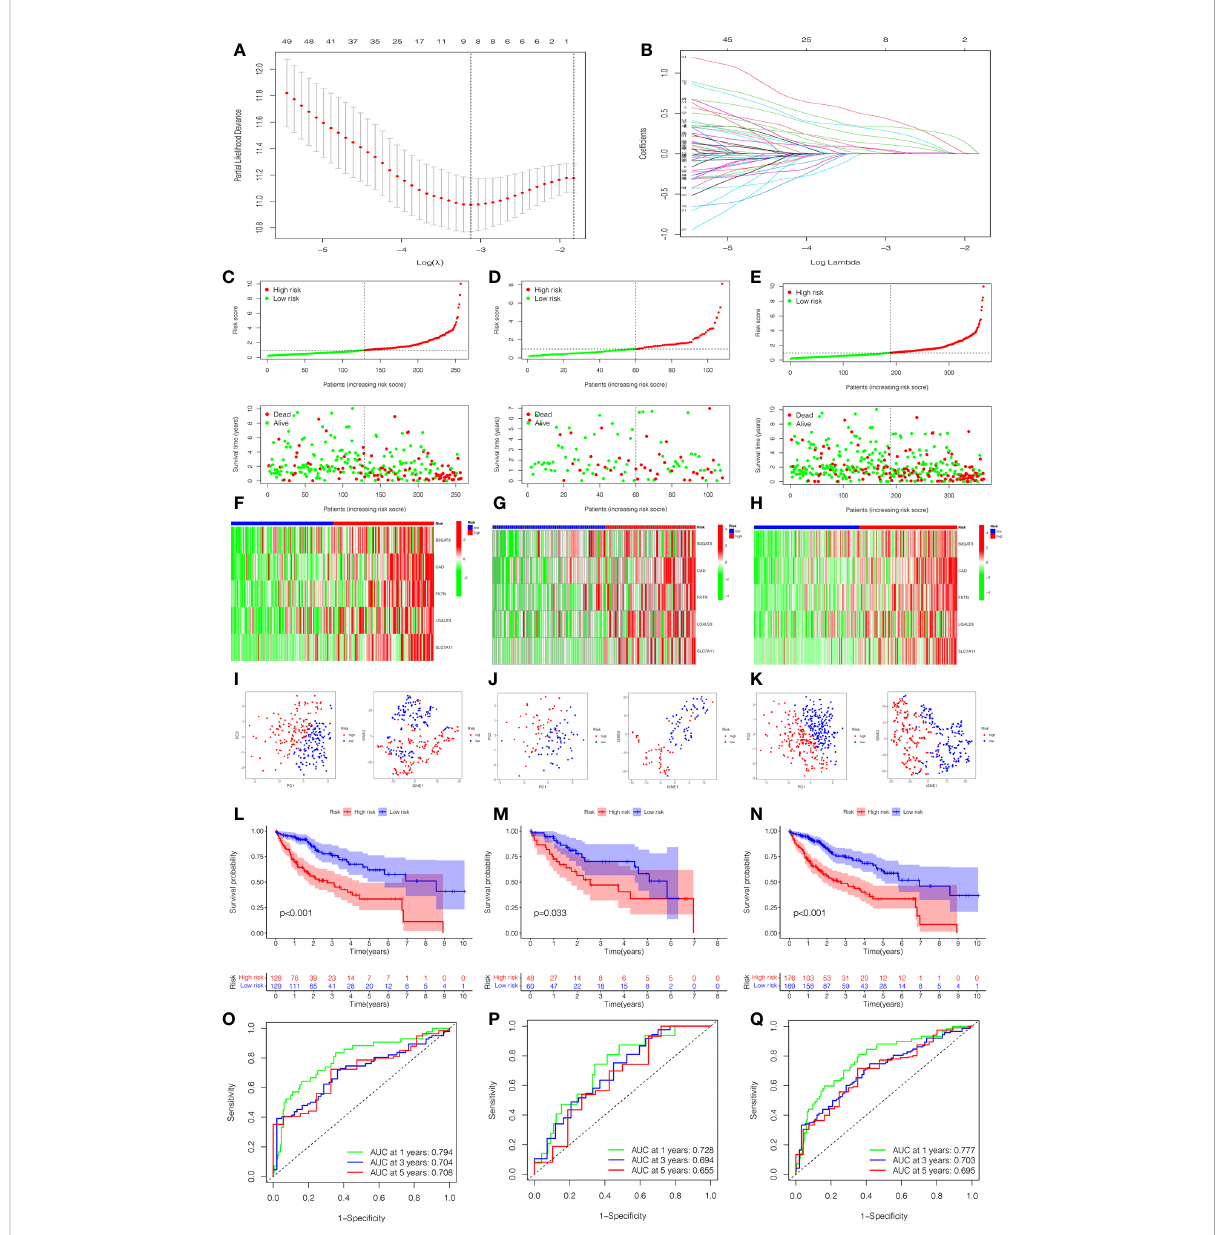
FIGURE 5 Construction and estimation of the glycosylation-related signature. (A) LASSO coef fi cient distribution of the glycosylation-related signature. (B) The optimal parameter ( l ) selection by the cross-validation curve. The distribution and survival status of the risk score in the training cohort (C) , testing cohort (D) , and total cohort (E) . Heatmap of fi ve-gene expression between low- and high-risk groups in the training cohort (F) , testing cohort (G) , and total cohort (H) . The PCA and t-SNE analysis in the training cohort (I) , testing cohort (J) , and total cohort (K) . (L – N) The K-M survival analysis between low- and high-risk groups in the training cohort (L) , testing cohort (M) , and total cohort (N) . The AUC values of ROC curves for 1, 3, and 5 years in the model in the training cohort (O) , testing cohort (P) , and total cohort (Q)